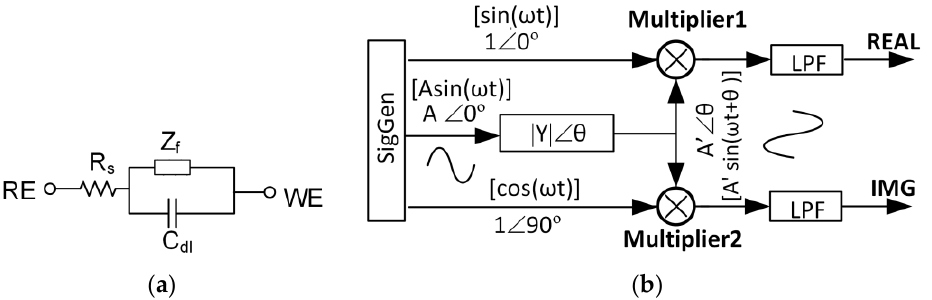
Figure 13. ( a ) Impedimetric sensor circuitry model where C dl represents double-layer capacitance, R s denotes solution resistance and Z f represents Faradic components. ( b ) Frequency response analyzer (FRA) method for extracting transducer impedance/admittance. Both phasor domain and time domain signal expressions are given. ω is the stimulus signal frequency. |Y| ∠ θ is the phasor form of the transducer admittance. Asin( ω t ) is the stimulus voltage for the electrochemical transducer. A'sin( ω t + θ ) is the output current of the transducer. sin( ω t) and cos( ω t) are the reference signals to extract the real part of imaginary part of the signal. LPF is the low pass filter. REAL and IMG are two orthogonal outputs, representing real and imaginary components of impedance/admittance.